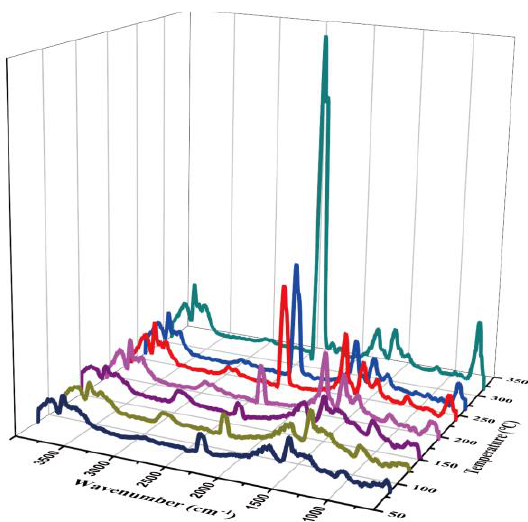
Figure 7. Thermogravimetric infrared three-dimensional diagram of COF-TpPa-1 without Soxhlet extraction in the temperature range of 0–350 °C.